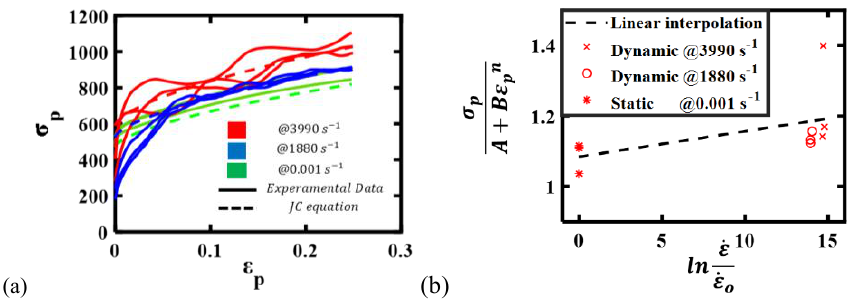
Fig. 6. Dynamic strain-stress response of stainless steel 316L made by SLM. Table 2: Mechanical response and constitutive parameters of stainless steel 316L made by SLM. Young’s modulus, 𝑬